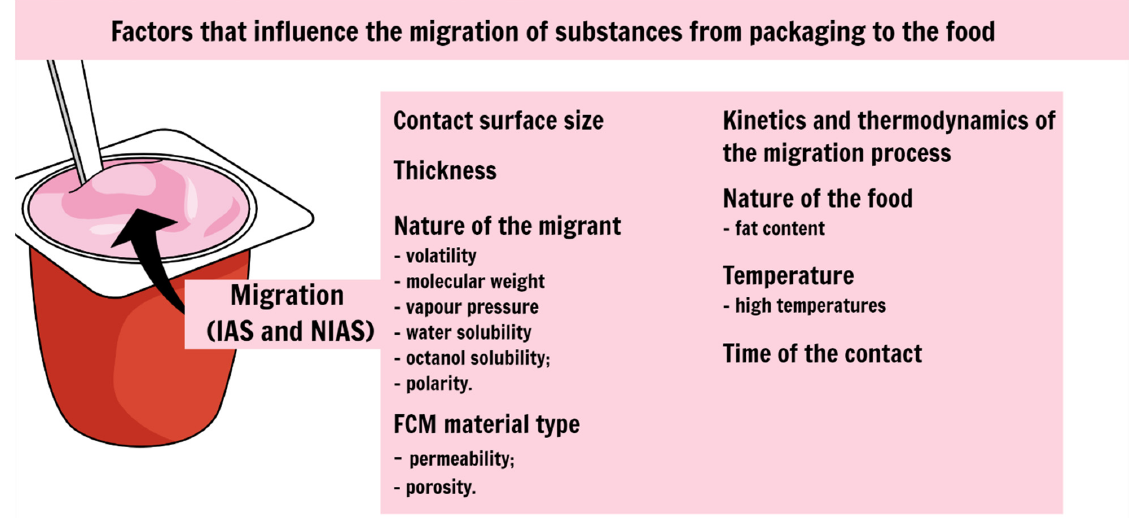
Figure 1. Main factors that influence the migration of substances from packaging to food. In the specific case of plastics, non-inert materials, the migration can occur from the inner side of the packaging and internal layers due to diffusion processes [18,48,49]. Ac- cording to the deterministic model, the migration of substances from packaging to food occurs through diffusion, where there is a movement of molecular structures from the high concentration to the low concentration region until equilibrium is reached. Fick’s second law can describe the diffusion rate [10,50–53]. Some studies describe precisely how to use this mathematical model [42,47,53]. In addition to diffusion, there is also desorption of diffuse polymer surface molecules, sorption of compounds at the plastic-food interface and desorption of compounds in the food that describe the migration stages [24]. Migration modelling can complement or substitute actual laboratory migration ex- periments that are expensive and time-consuming. Thus, it has become a popular tool for researchers, industry and regulators to predict migration. Efforts have been made to mod- ify the standard “worst-case” deterministic models to reflect more realistic migration sce- narios better. These approaches comprehend probabilistic and stochastic modelling that considers variability and uncertainty in the mass transfer parameters, mechanistic or em- pirical migration models that can be combined with food consumption data to estimate dietary exposure to the chemicals [17,54–56]. However, trained specialists should only use migration models with in-depth knowledge of chemical migration to make reliable pre- dictions and correctly interpret the results. Gavriil et al. [55] published an extensive review to evaluate the migration models’ efficiencies, concluding that these models cannot pre- dict the total accurate migration from a different FCM to the food volume since the mate- rial might contain several completely unknown compounds. Thus, the migration studies are still the traditional method for evaluating the migration of substances from packaging to food, despite analytical challenges and cost. Two terms of high significance that should not be confused are the overall migration (OM) and the specific migration (SM). The OM refers to the sum of all mobile substances of packaging released per unit area of the package under the influence of specific prede- termined conditions. On the other hand, SM is only related to a specific known substance [57]. In most cases, and as provided by legislation ((EU) n° 10/2011), the migration study is performed with food simulants in place of the food itself, due to the high complexity that food has typically as a matrix than foods [29,58,59]. They should represent the signif-